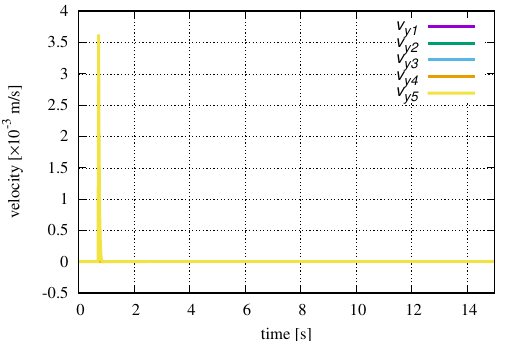
Figure 38. Case 3: Time variation of estimation error of the velocities in the axial